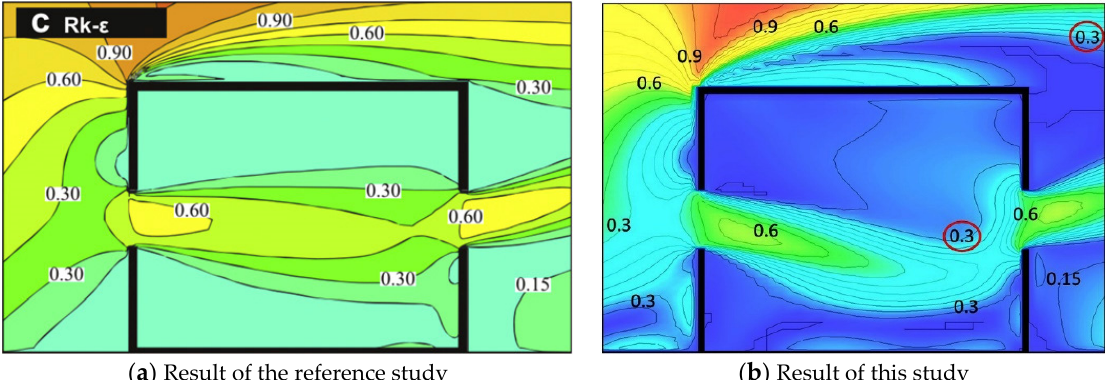
Figure 9. Wind speed ratio contours in the vertical center plane: ( a ) result of the reference study; and ( b ) result of this study. The red / orange colors in the figures represent higher wind speed ratios